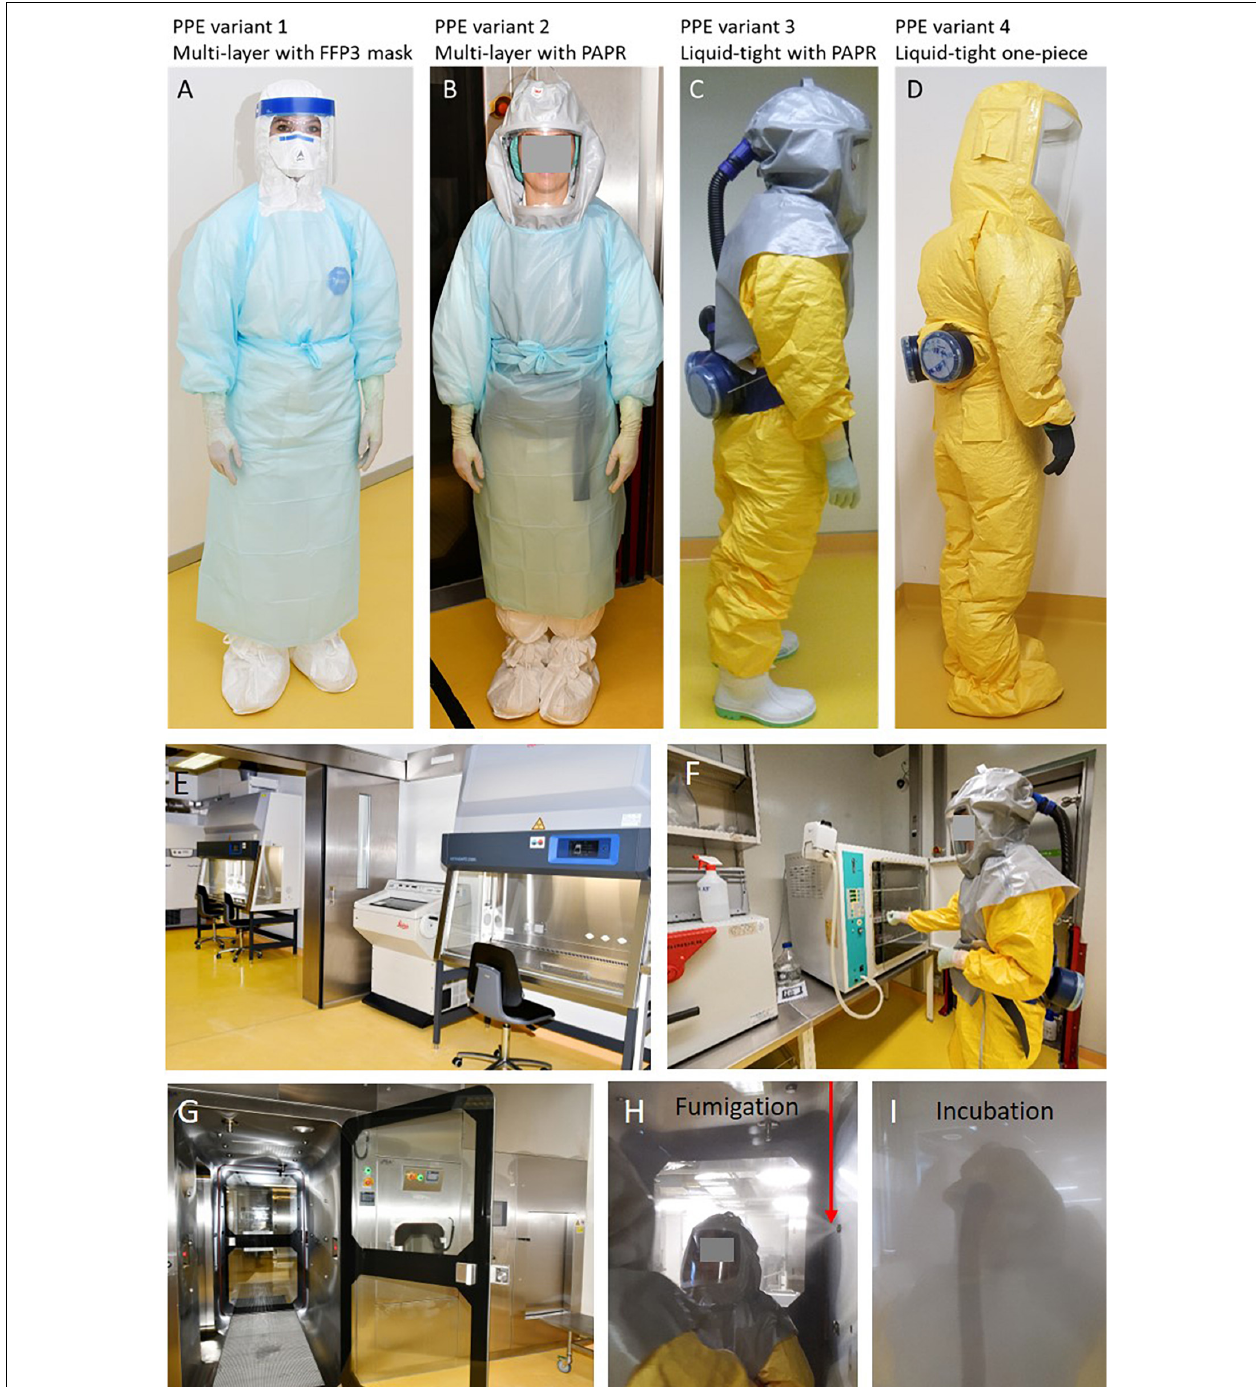
FIGURE 1 | (A) Personal protective equipment (PPE) variant 1 consists of a single-use coverall (Cat. III, type 4-B/5-B/6-B), apron with long sleeves, a double layer of shoe covers worn over crocs, a double layer of differently colored gloves, e.g., green nitrile gloves as the inner layer and white gloves as the outer layer, FFP3 mask, goggles and face shield. (B) PPE variant 2 corresponds with variant 1 but FFP3 mask, goggles and face shield are replaced by a powered air-purifying respirator (PAPR, e.g., Jupiter TM Air Filter Unit with two A2BEKP filters and 8 h rechargeable batteries) connected to a hood assembly providing head, face and shoulder coverage. (C) PPE variant 3 consists of a Tychem 2000C protective suit (Cat. III, Type 3/4/5/6) which protects against biological substances, and is impermeable to liquid and particles. Outer layers of gloves and chemical protective boots are sealed with adhesive tape. The hood is ventilated by the same PAPR used in